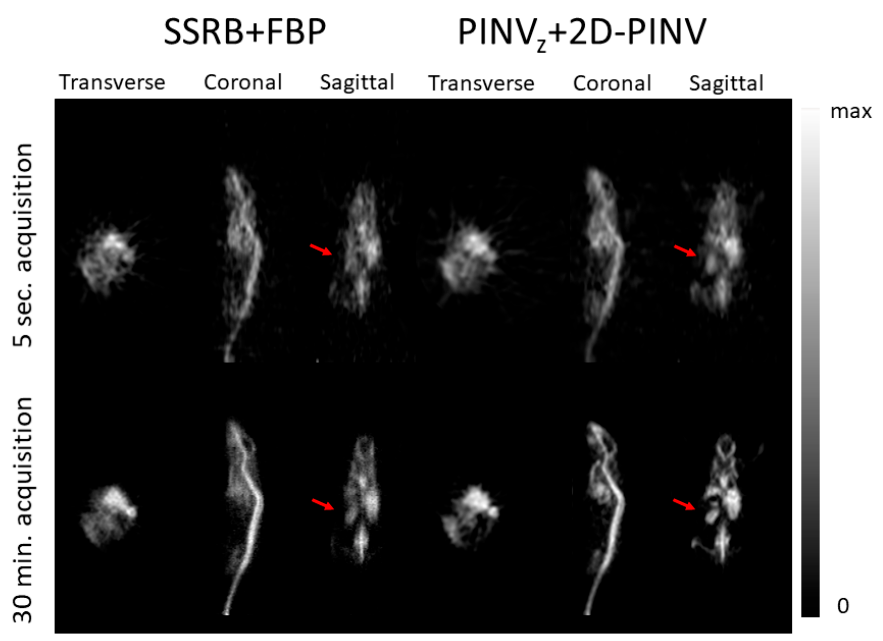
Figure 10. ( Left ) SSRB + FBP and ( right ) PINV z + 2D-PINV image reconstruction of a rat injected with 300 µ Ci 18 FDG. The transverse, coronal and sagittal views are shown for a slice of the image. Top ( bottom ) panel shows 5 s (1800 s) acquisition.